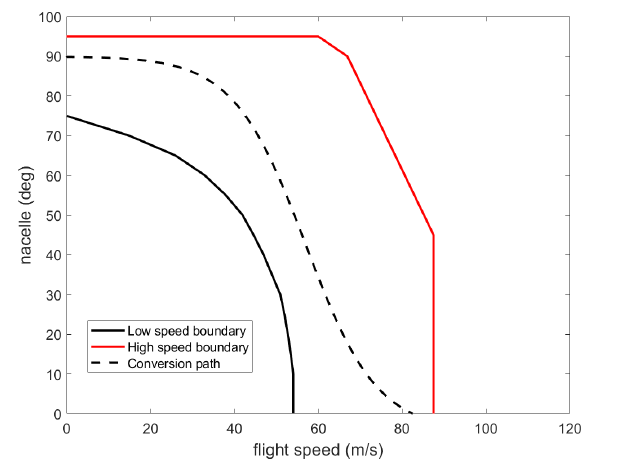
Figure 5. The time curves of fight speed and